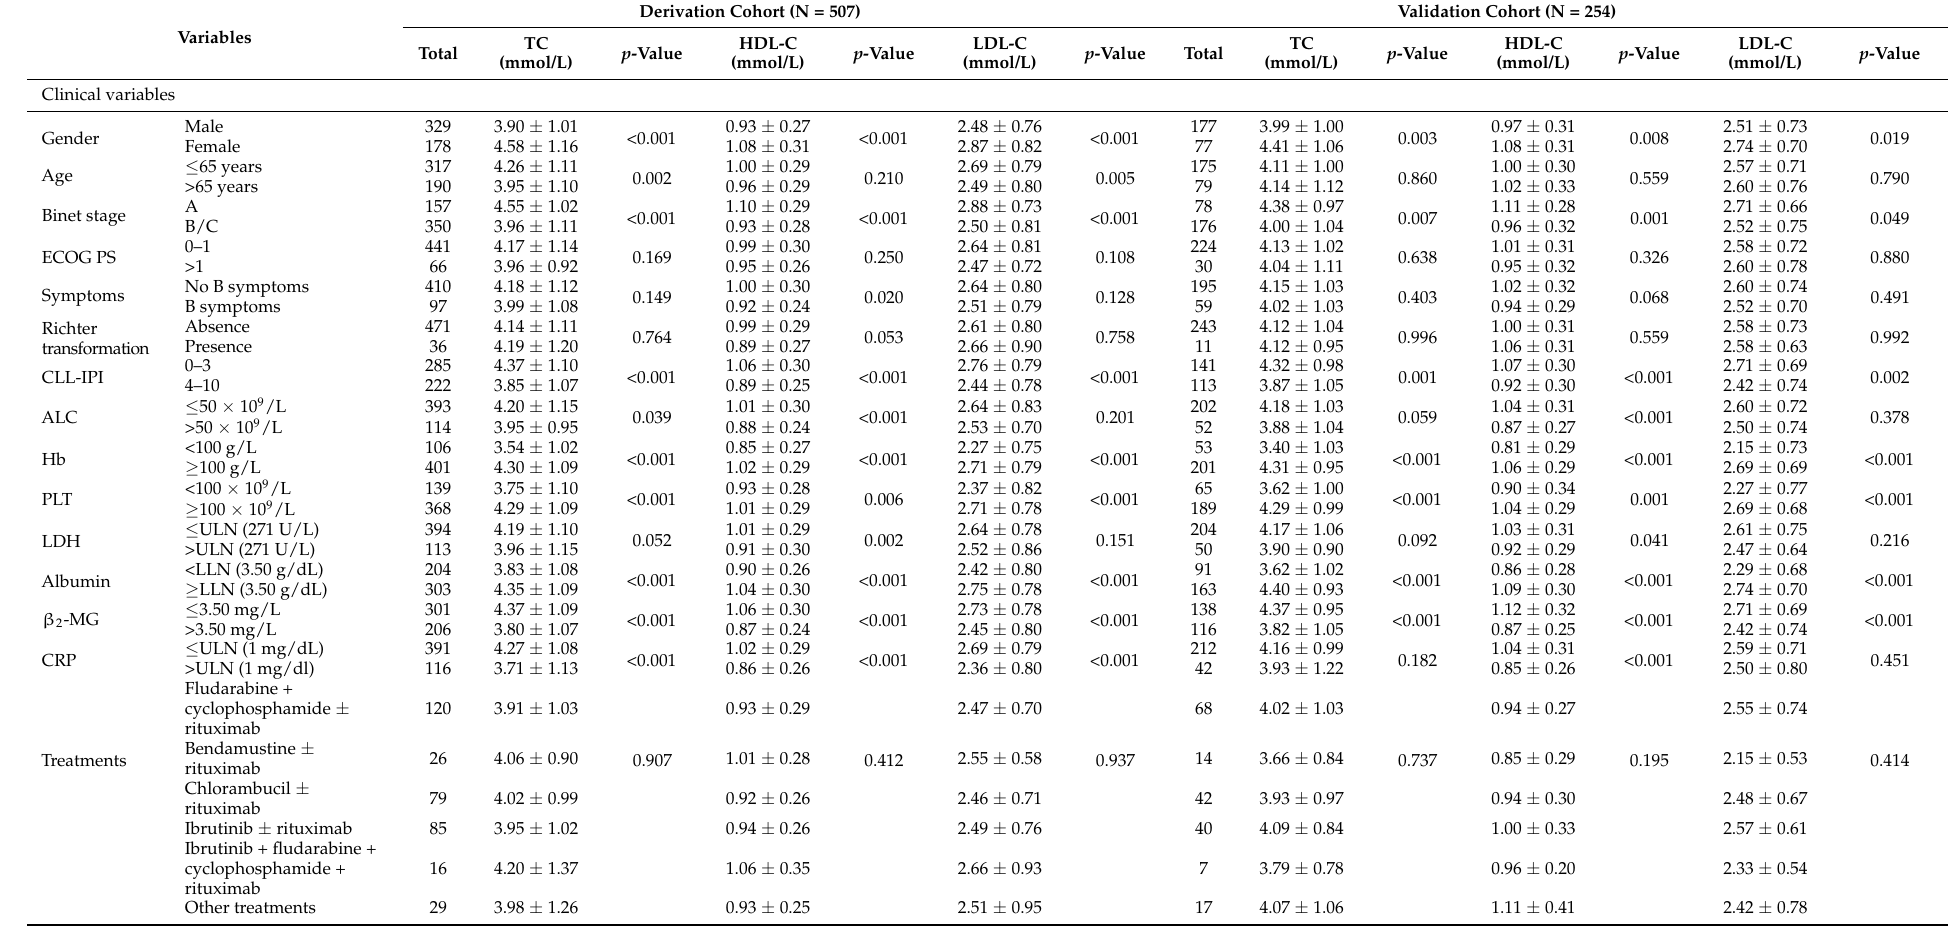
Table 1. Difference in serum cholesterol levels stratified by clinical characteristics in the enrolled CLL